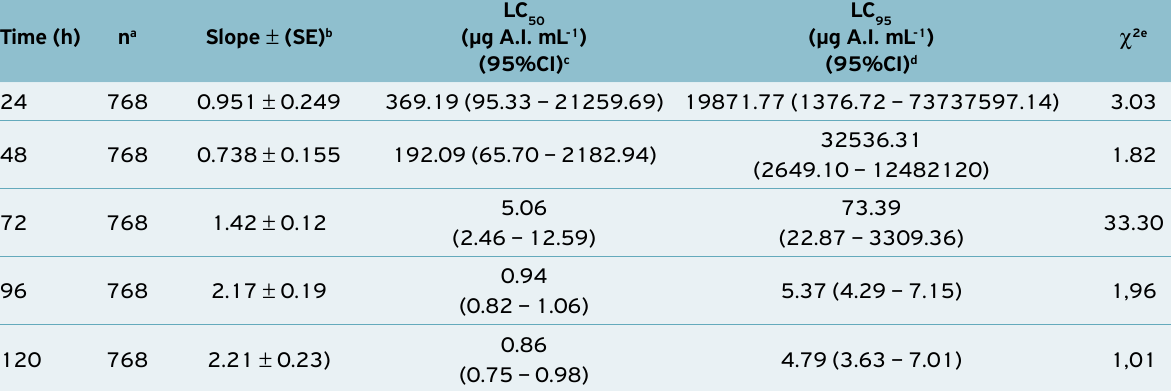
Table 2. Evaluation of mortality-time of C. includens (SUS) to lufenuron.